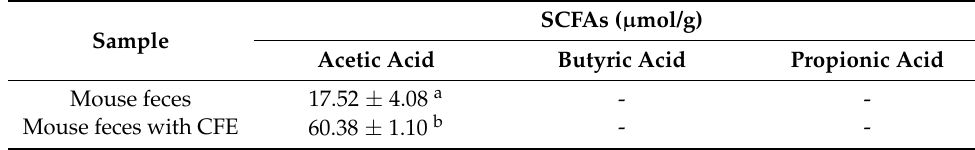
Table 3. SCFAs contents after in vitro fermentation of CFE by mouse feces.